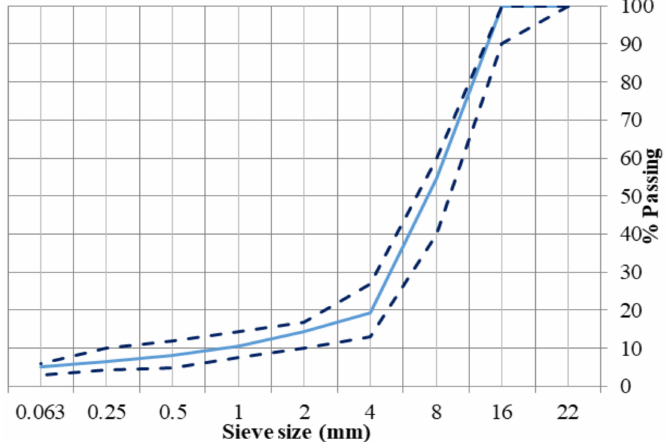
Figure 1. Gradation of PA